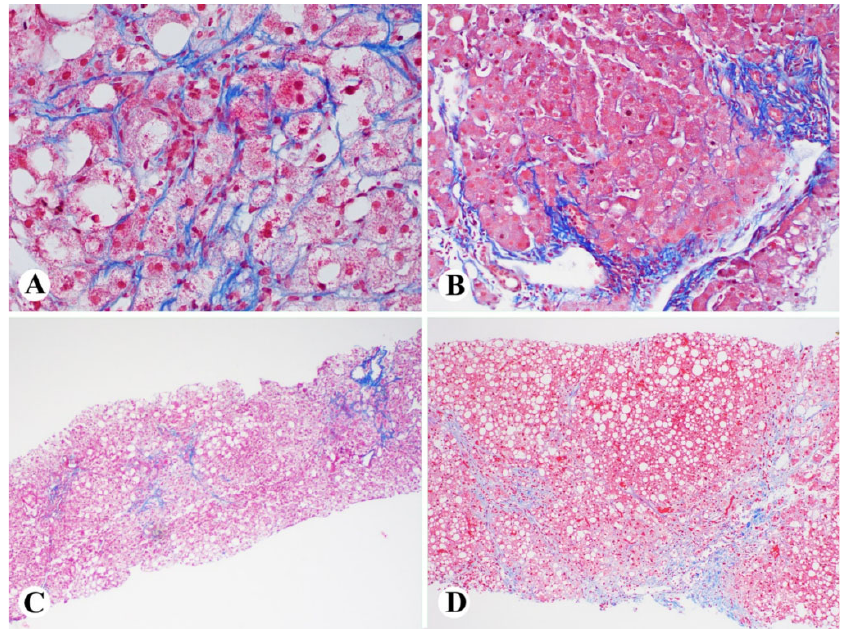
Figure 2. Fibrosis staging of steatohepatitis: ( A – D ), Trichrome stain highlighting the perisinusoi ‐ dal/pericellular fibrosis ( A ); periportal fibrosis ( B ); perisinusoidal/pericellular fibrosis and peri ‐ portal fibrosis (Stage 2, C ) and bridging fibrosis (stage 3, D ) ( A , 400×; B, 200×; C , D , 100×).